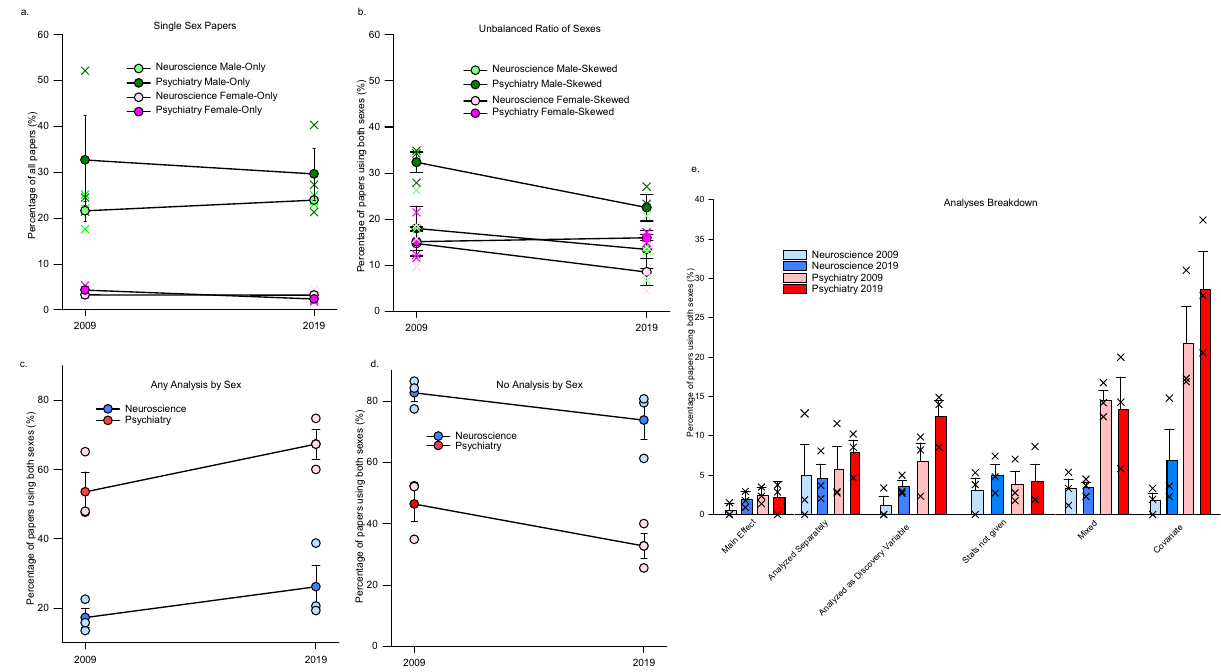
Fig. 4 Percentage of papers sampled in 2009 and 2019 in neuroscience and psychiatry, which used only a single sex in the paper or which used both sexes, and the breakdown of types of analyses used. Plotted are the percentage of proportional papers within each journal and year, n = the number of research papers within each category. a Percentage of papers reporting studies using only one sex across years and disciplines. Male-only papers (26.96%) were 8.2 times higher than female-only (3.29%) papers (main effect of sex: F (1,8) = 324.39, p < 0.0001; number of papers: